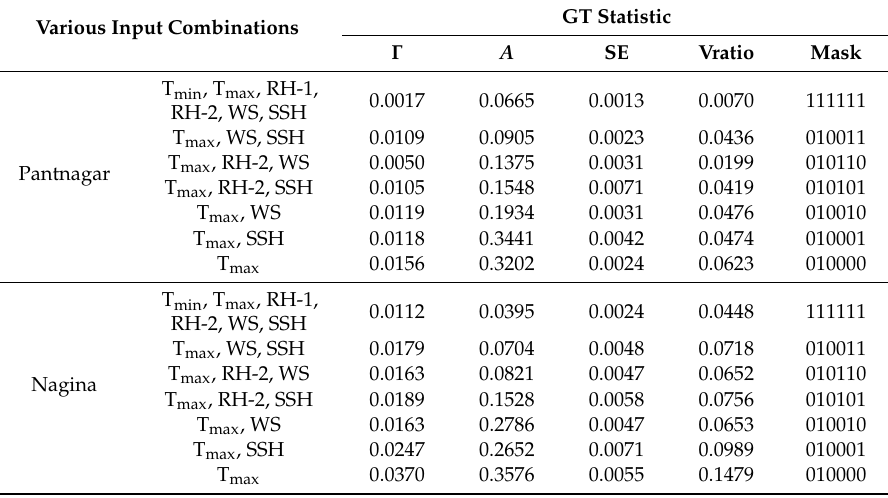
Table 4. Gamma test (GT) results on di ff erent input combinations at the study